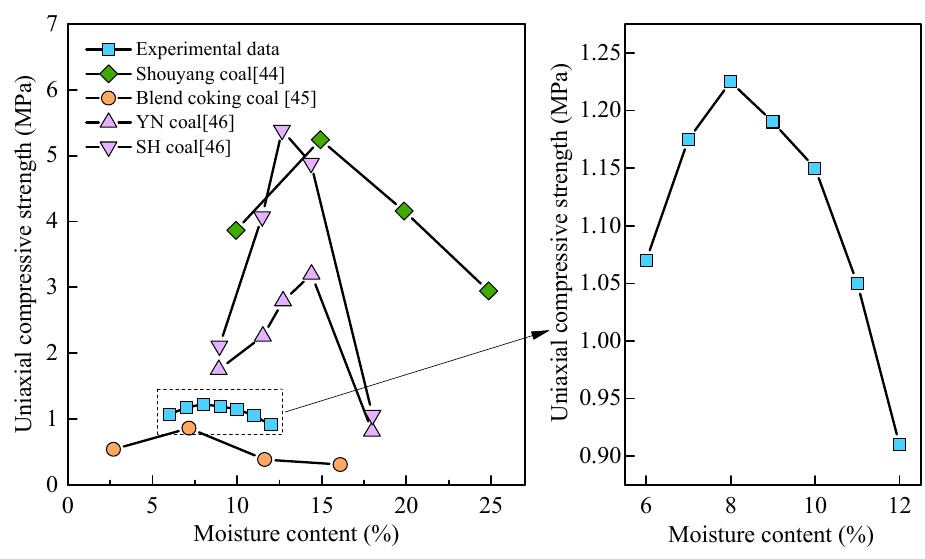
Figure 11. Effect of moisture content on uniaxial compressive strength of reconstitute coal .